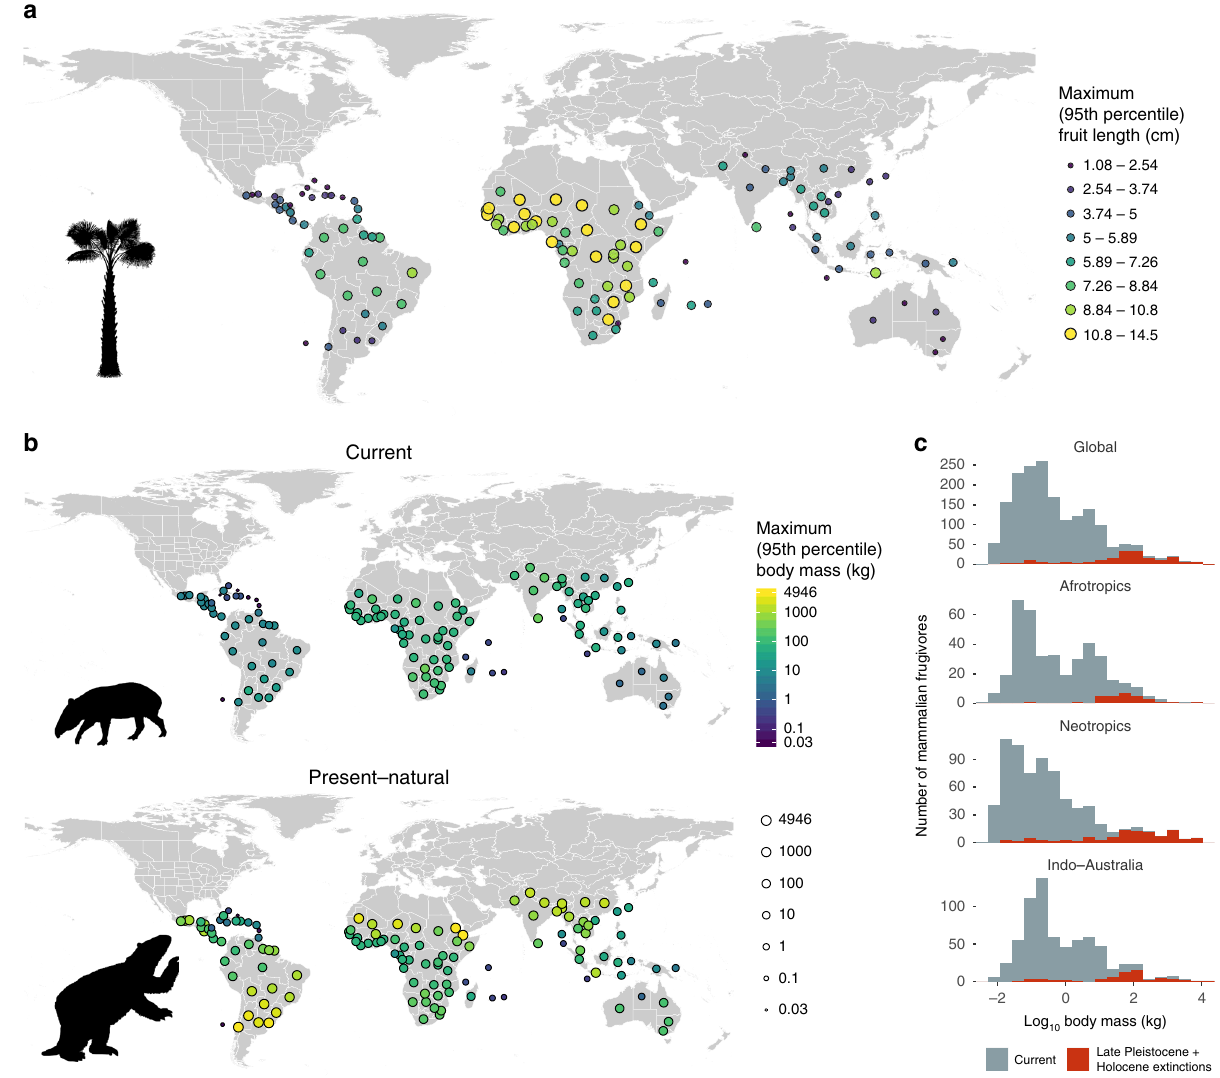
Fig. 1 Global distribution of palm fruit sizes and mammalian frugivore body sizes. Maps show maximum (95th percentile) values of a palm fruit sizes, and b mammal frugivore body sizes across all species within botanical countries. The “ current ” scenario is based on present-day distributions of extant mammalian frugivores, whereas the “ present – natural ” scenario is based on the distribution of all mammalian frugivores since the Last Interglacial (130 Kya), including all extant species as well as taxa that have gone extinct within that time frame. Values are represented by a colored circle plotted at the centroid of each botanical country, with brighter colors and larger circles representing higher values. In c , frequency distributions of body sizes of extant frugivorous mammals (gray) as well as frugivorous mammals that went extinct at the end Pleistocene and Holocene (red) are illustrated globally and within biogeographic realms. All organism silhouettes obtained from http://phylopic.org. We additionally acknowledge Julian Bayona (Zimices) for the silhouette of Mylodon , under a CC-Attribution-NonCommercial 3.0 Unported License (https://creativecommons.org/licenses/by-nc/3.0/). Source data are provided as a Source Data fi